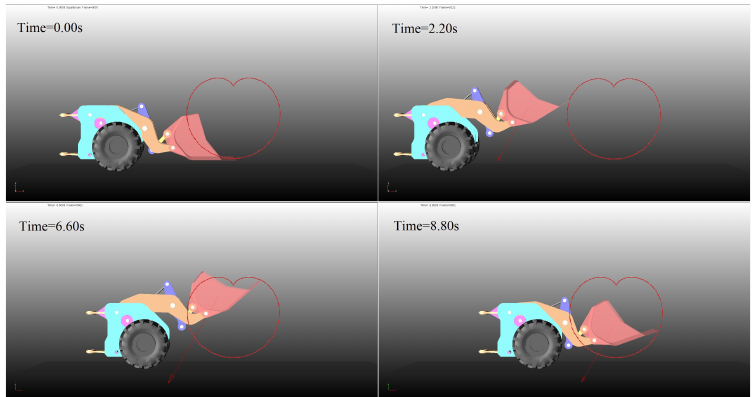
Figure 12. Dynamic simulation